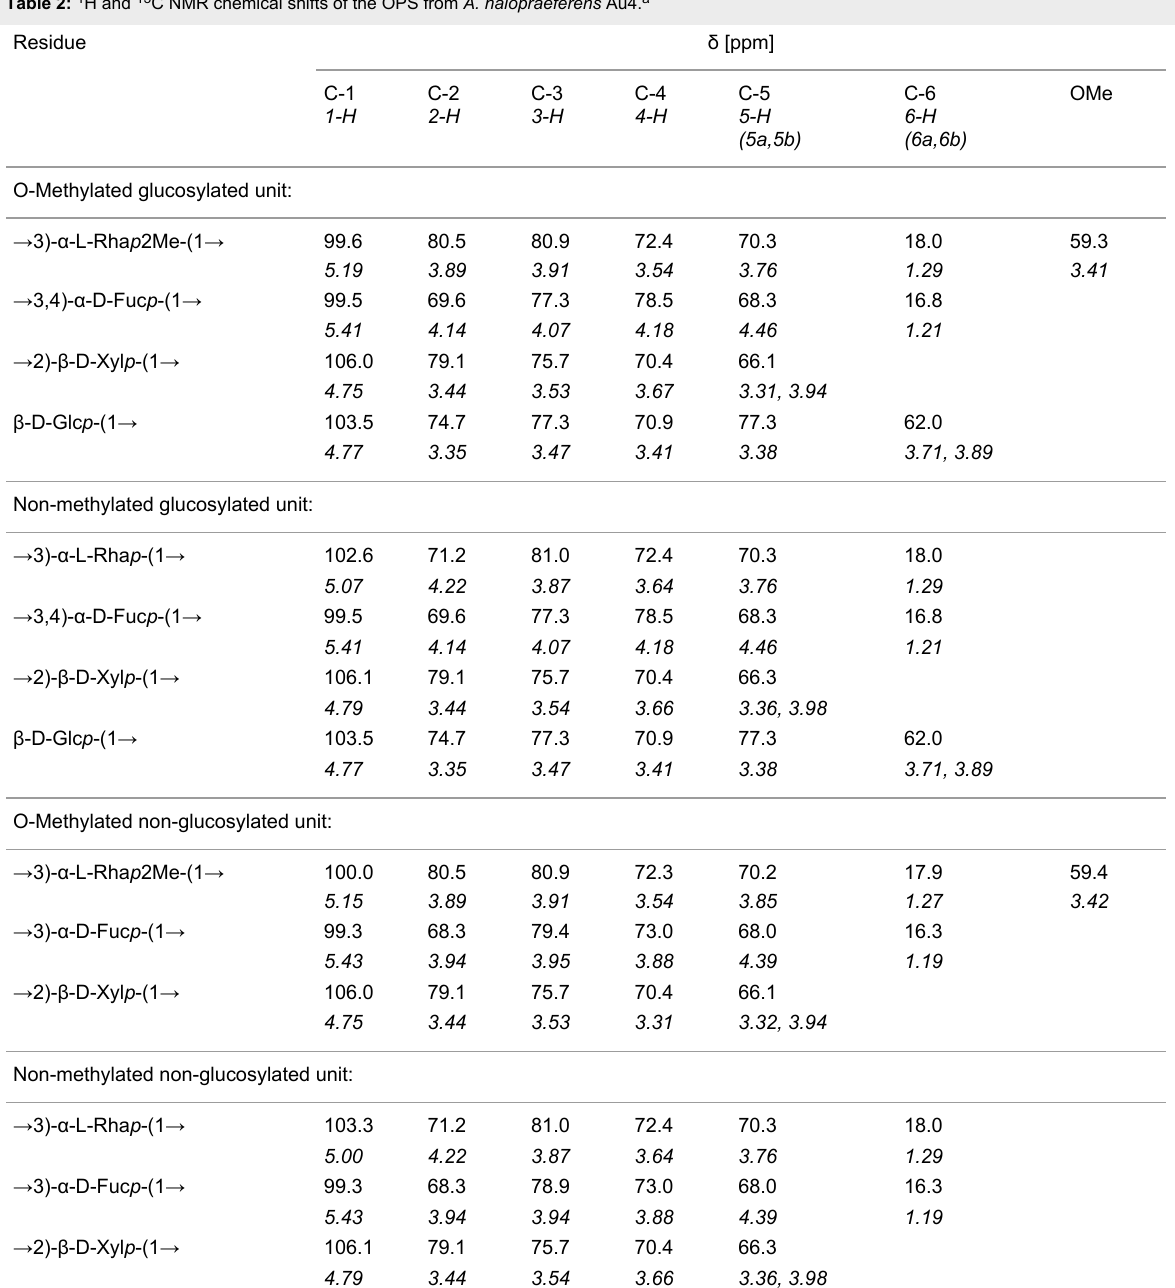
Table 2: 1 H and 13 C NMR chemical shifts of the OPS from A. halopraeferens Au4. a